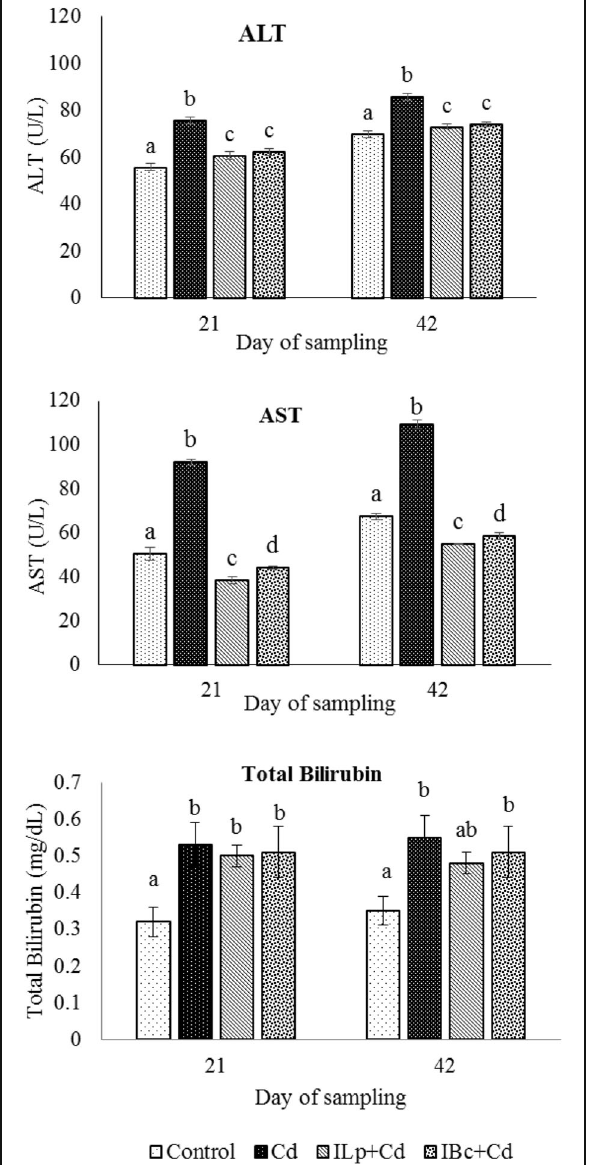
Fig. 2 Effects of oral administration of cadmium on levels of ALT, AST and total bilirubin of rats fed symbiotic diets at days 21 and 42 of treatments. Cd: cadmium; ILp + Cd: inulin, Lactobacillus plantarum and cadmium; IBc + Cd: inulin, Bacillus coagulans and cadmium. All results are expressed as mean and standard deviation. The different letters indicate statistically significant differences ( P <